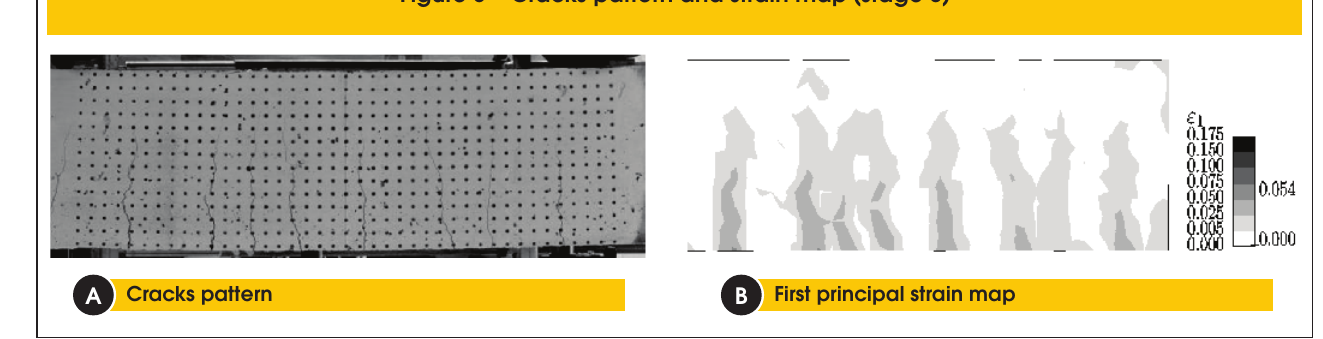
Figure 8 – Cracks pattern and strain map (stage 3)